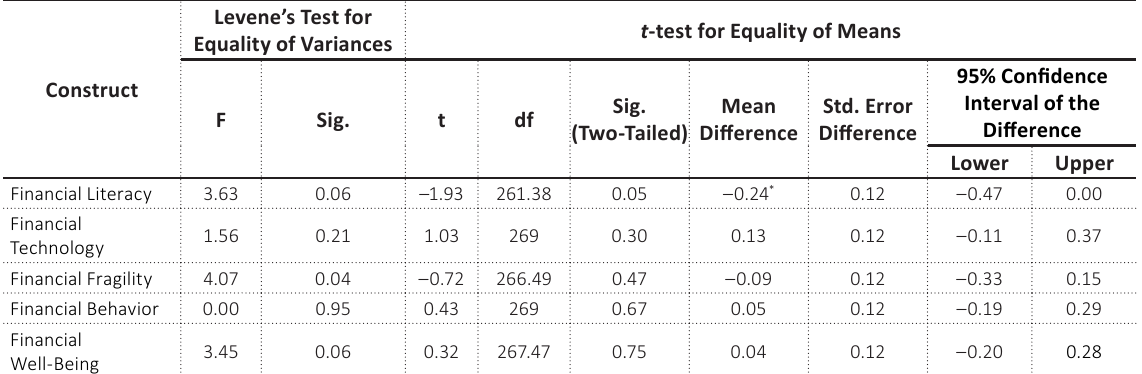
Table 9. Independent sample t -tests for financial well-being and its factors by gender